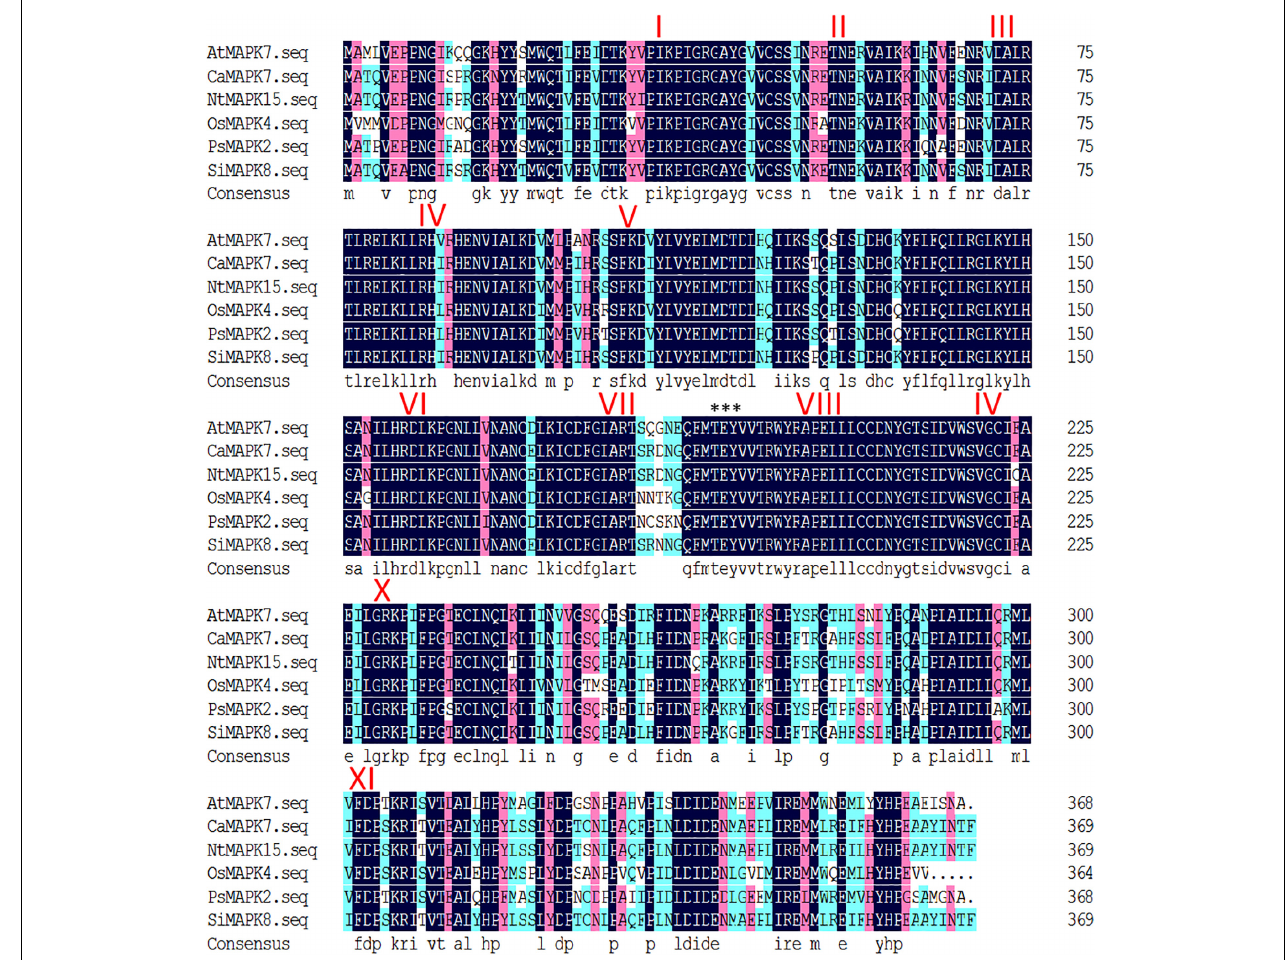
FIGURE 1 | Amino acid sequence arrangements and phylogenetic analysis with the CaMAPK7 protein and its orthologs. Amino acid sequence alignments of CaMAPK7 and its orthologs from Arabidopsis thaliana (AtMAPK7), Oryza sativa (OsMAPK4), Pisum sativum (PsMAPK2), Solanum lycopersicum (SlMAPK8), and Nicotiana tabacum (NtMAPK15). The 11 conserved domains (I–XI) present in the serine/threonine protein kinases are denoted by Roman numerals. The conserved threonine and tyrosine residues are indicated by asterisks